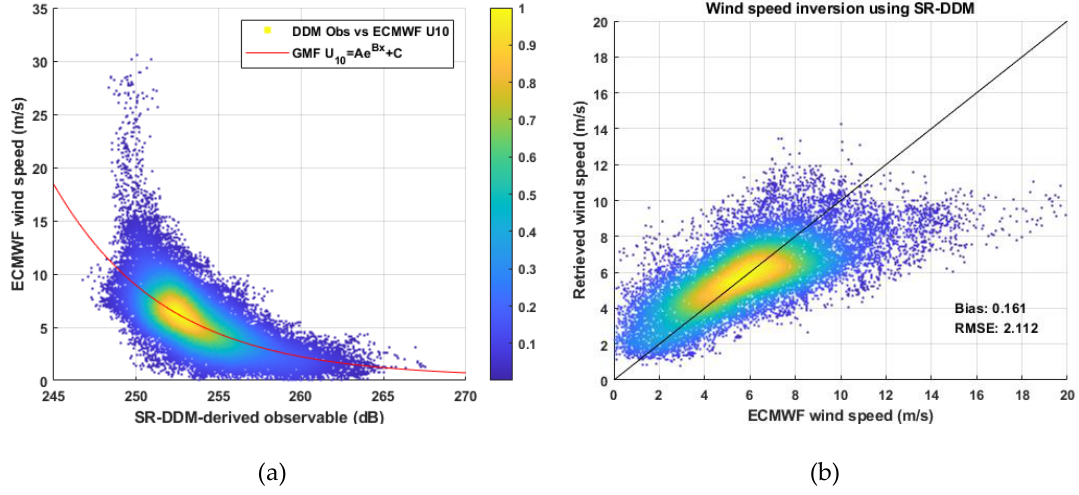
Figure 13. ( a ) SR-DDM-derived σ 0 versus interpolated ECMWF wind speed for the training data set with the fitted GMF (in red) of the form U 10 = Ae Bx + C ; ( b ) SR-DDM retrieved with the fitted GMF versus collocated ECMWF wind speed for the test data set.